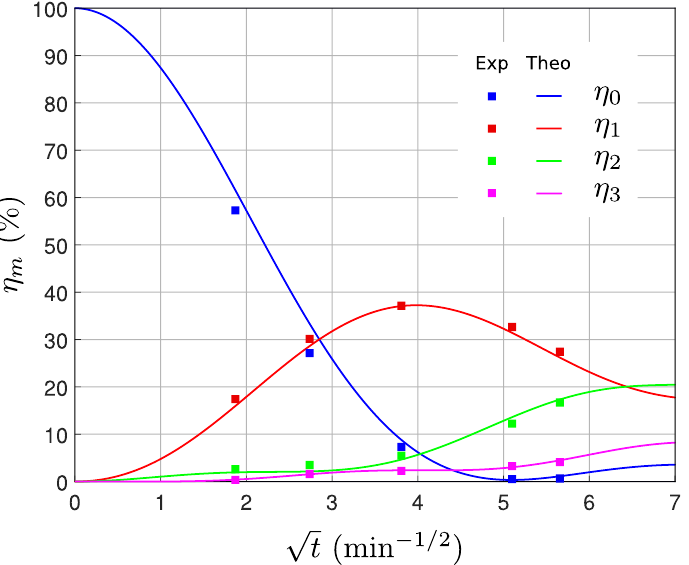
Figure 5. Plot of the efficiencies of the orders 0 (blue line), ± 1 (red line), ± 2 (green line), and ± 3 (magenta line) with the square root of the ion-exchange time according to Equations (7) and (8) and Figure 4. The experimental efficiencies of the five gratings used in this work are also